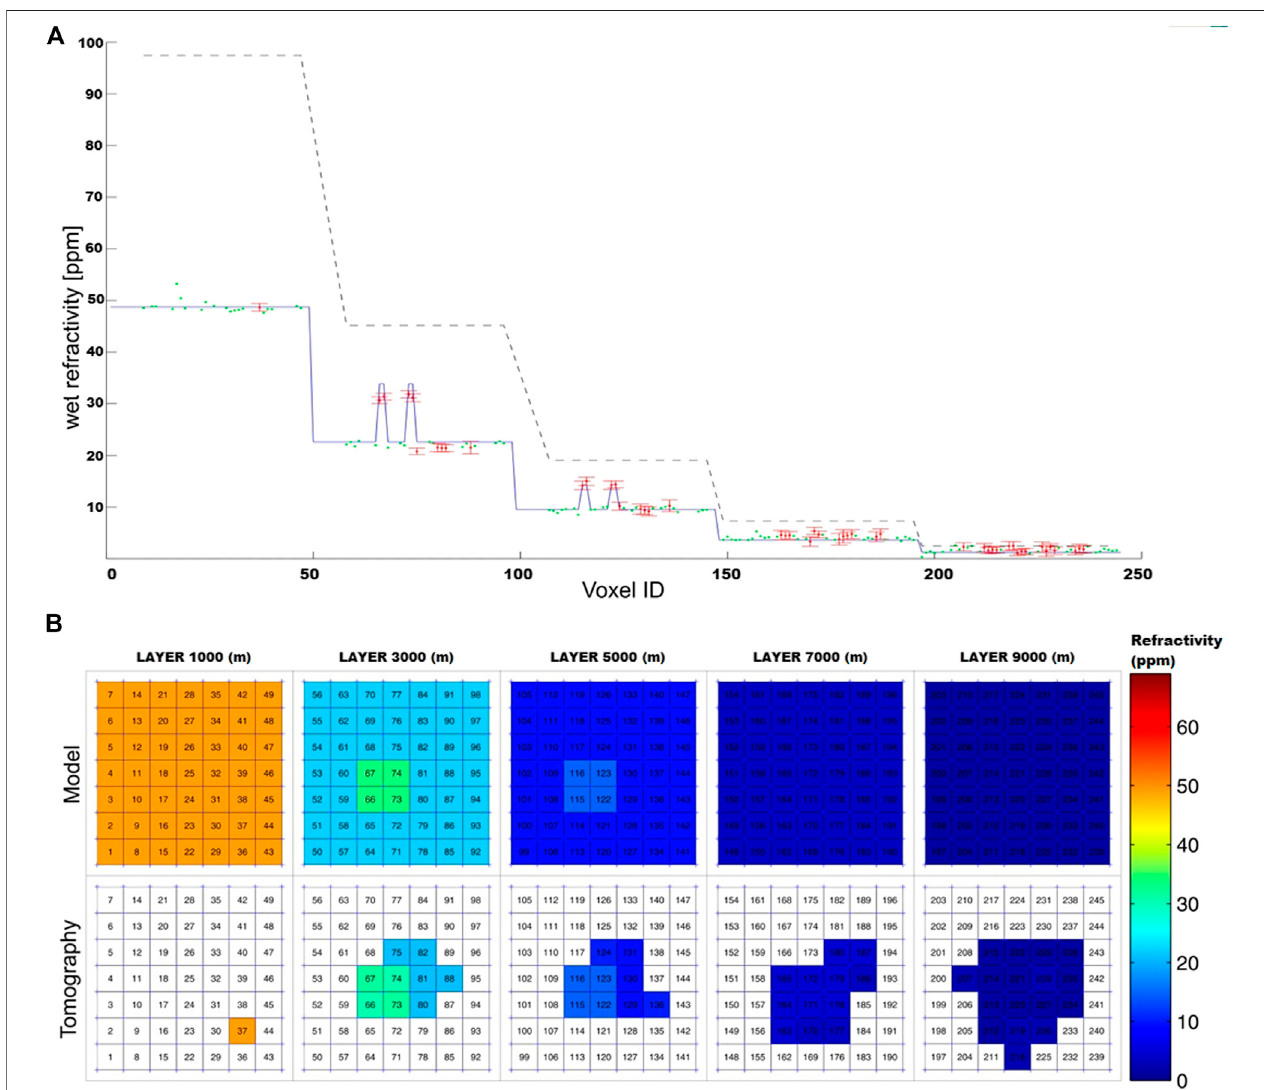
FIGURE6|(A) Wetrefractivity fi eldvs.voxel,rankedaccordingtothepositionofthevoxelinthematrix (B) .Dashedblacklinesrepresentthephysicalconstraintsforthe tomographicsolution(saturationatthedifferentelevations).Thebluelineisthewetrefractivitystartingmodel.Thegreenpointsarethenumericresultsofallthevoxelsinwhich it is possible to calculate a refractivity value. The red points represent the refractivity values of the voxels considered to be acceptable according to the fi xed thresholds (damping and SF), that is, the result of the tomography. (B) tomography results: the fi rst row refers to the reference model, and the second row is the reconstructed tomography. The voxels are numbered from lower to upper layer and from south to north, in cardinal numbers. The tomography images show only the voxels over the SF threshold, the others are blank. Results are plotted according to the color scale on the right. The considered volume refers to the model shown in Figure 5 .